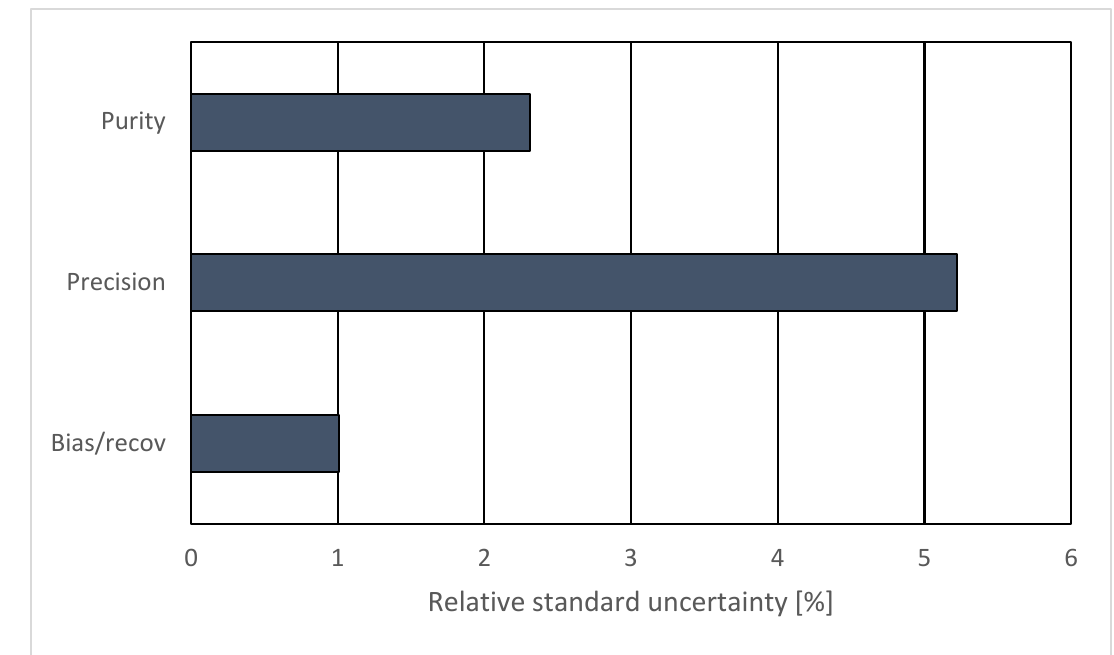
Figure 3. The relative standard uncertainty contribution for each parameter considered in the uncertainty measurement. Figure 4 presents the calculated expanded uncertainty for the different MDA concen- tration in EBC, using a coverage factor of 2. As expected, the lowest uncertainty ( ≤ 10%) was observed for MDA concentrations above 650 pg/mL, whereas it increased to 23% for MDA concentrations near the LOQ.